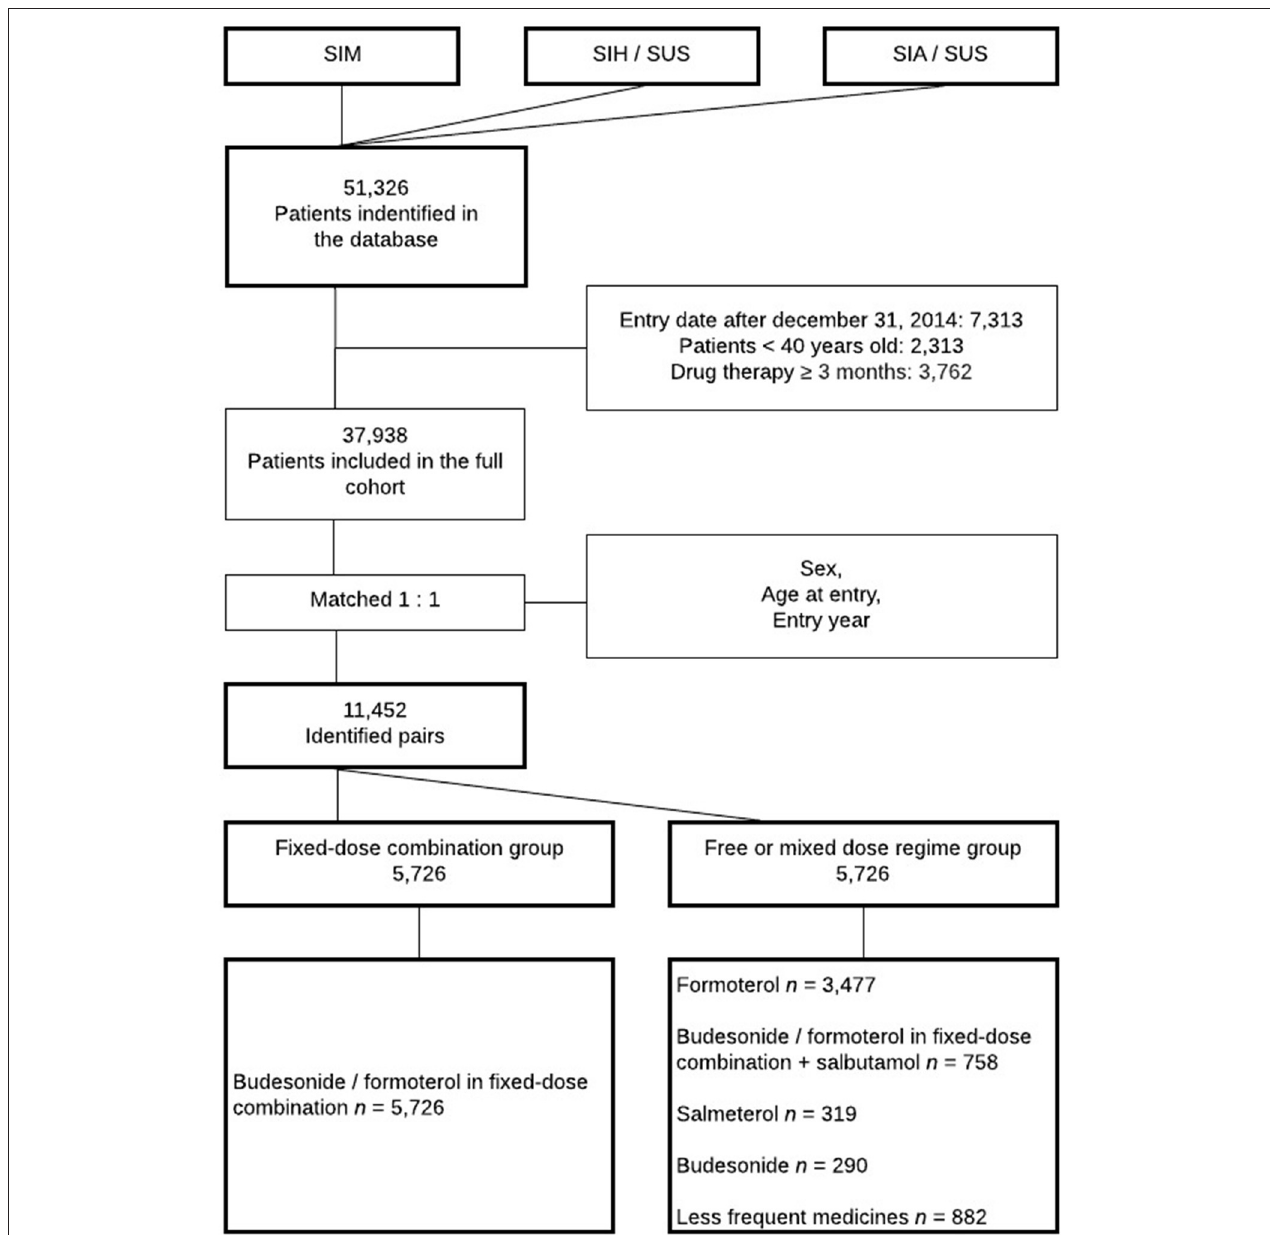
FIGURE 1 | Cohort selection flowchart. SUS, Brazilian National Health System; SIM, Mortality Information System; SIH/SUS, Hospital Information System, SIA/SUS Outpatient Information